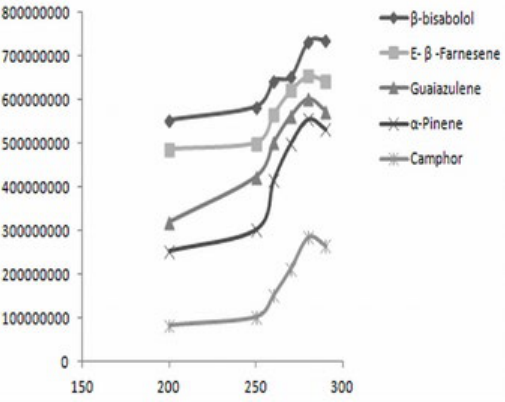
Fig. 6. Effect of time temperatures on the extraction efficiency. (X=min, Y=area